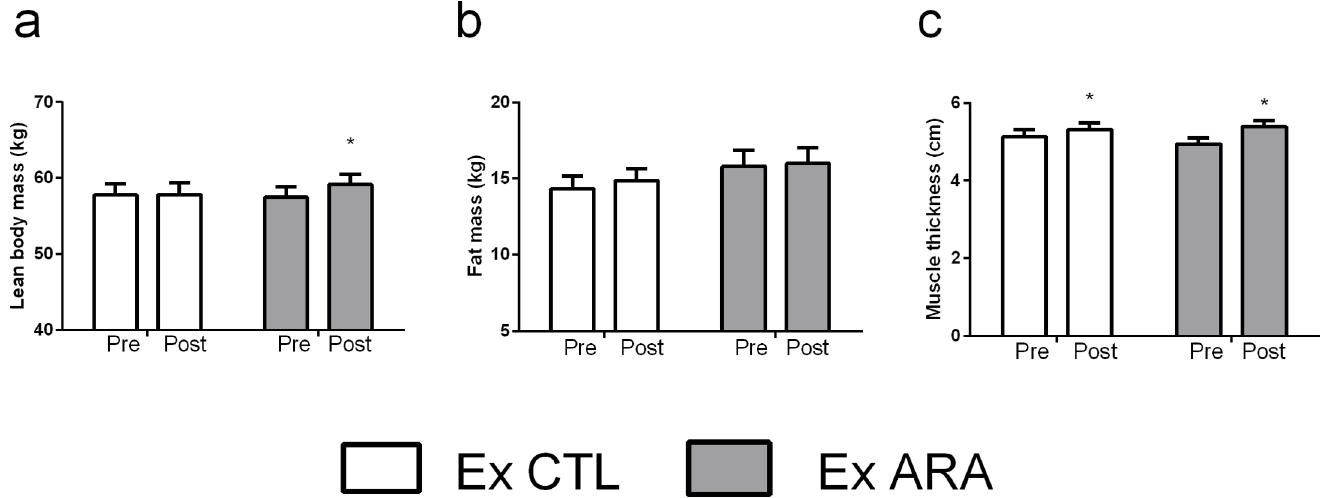
Fig 1. Pre- and post-testing values for lean body mass (a), fat mass (b), and muscle thickness (c) for Ex CTL and Ex ARA groups. * — Indicates p < 0.05 for within-group comparisons.